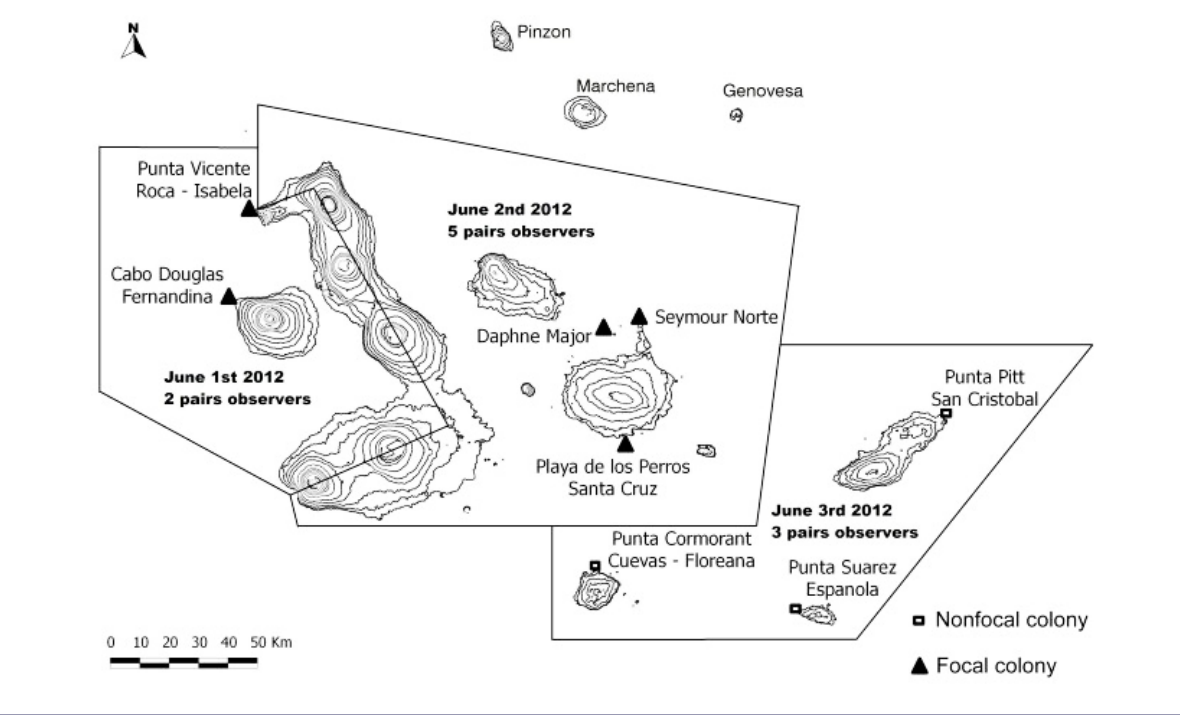
Fig. 2 . Location of focal and nonfocal colonies, islands, and sections scanned per day during the coastal survey of June